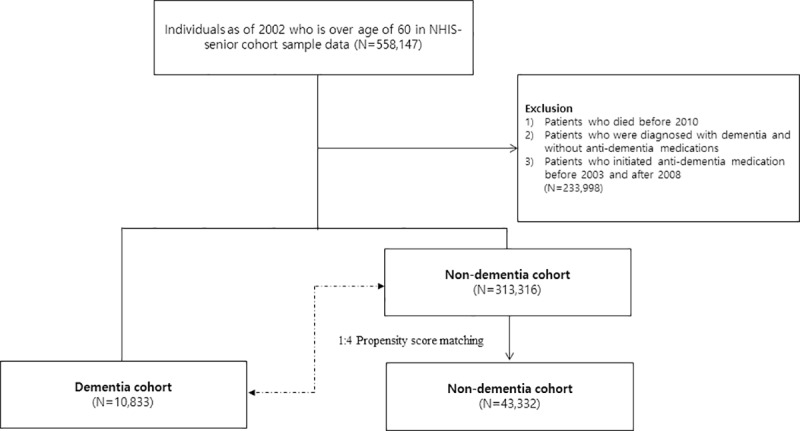
Flow of patient selection.NHIS; National Health Insurance Service.